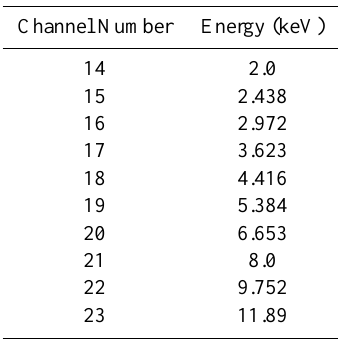
Table 1. The energy bin numbers and energy ranges inkeV for the TIMAS particle detector on board the Polar spacecraft which were used in the calculation of the free energy and slope of the positive gradient region in the text.